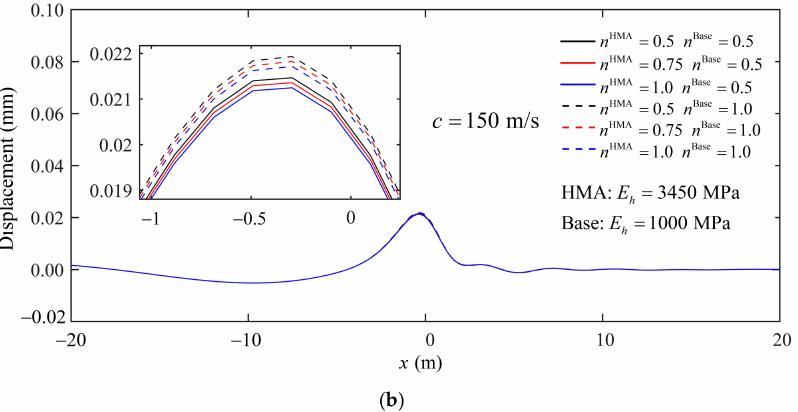
Figure 16. Effect of the layer modulus ratio, n = E h / E v , with a fixed horizontal modulus on the vertical displacement fluctuation amplitude along the x -axis, induced by a moving Gaussian load, with speeds of ( a ) c = 50 m/s and ( b ) c = 150 m/s.